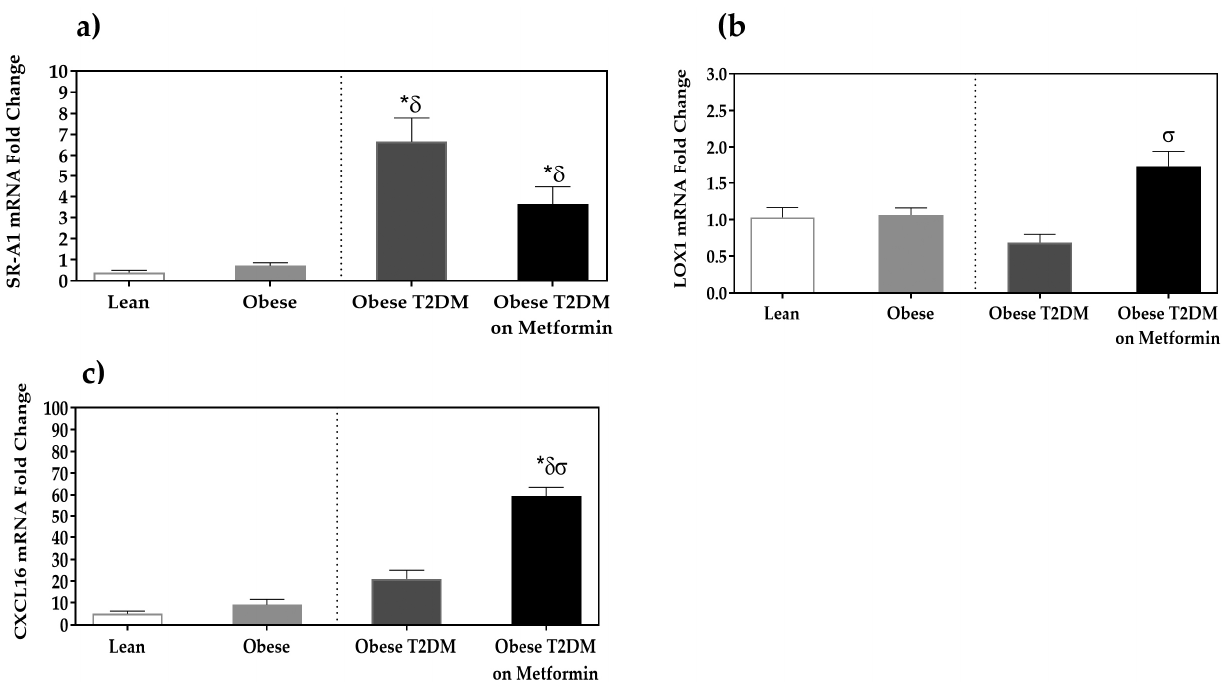
Figure 4. mRNA expression of scavenger receptors in the PBMCs of lean, obese, T2DM and T2DM on Metformin groups: ( a ) SR-A1; ( b ) LOX-1; and ( c ) CXCL16. Results are presented as Mean ± SEM. One-way ANOVA on ranks, p < 0.001 for SR-A1, LOX-1, and CXCL16, followed by Dunn’s test for pairwise comparisons and comparisons against normal-weight group, * p < 0.05 vs. normal-weight subjects; δ p < 0.05 vs. obese; σ p < 0.05 vs. T2DM subjects.